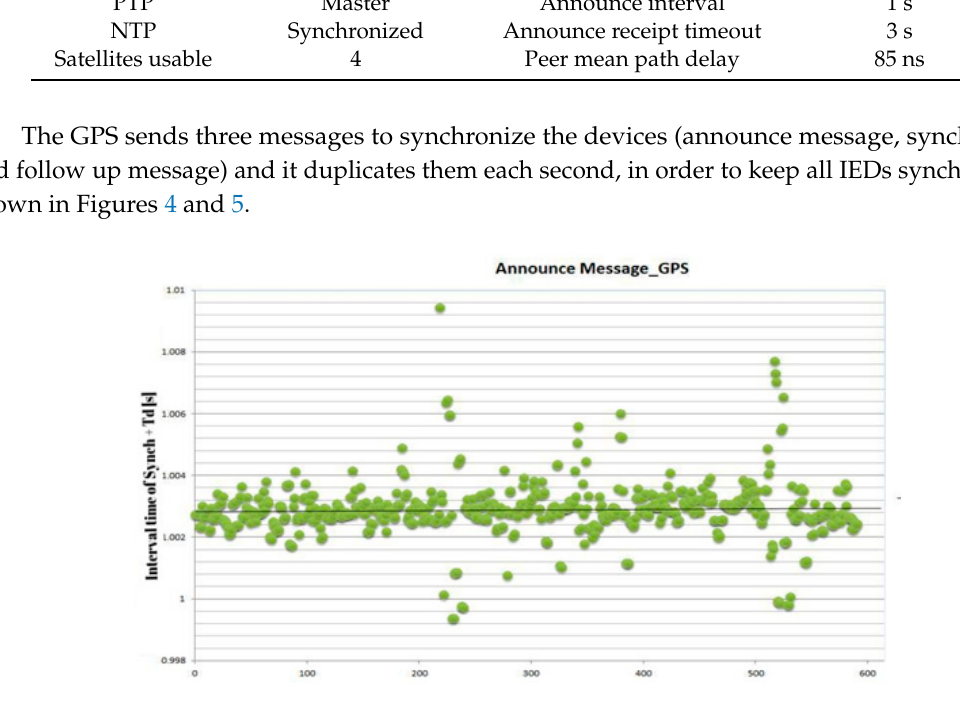
Table 2. PTP time synchronization and settings.